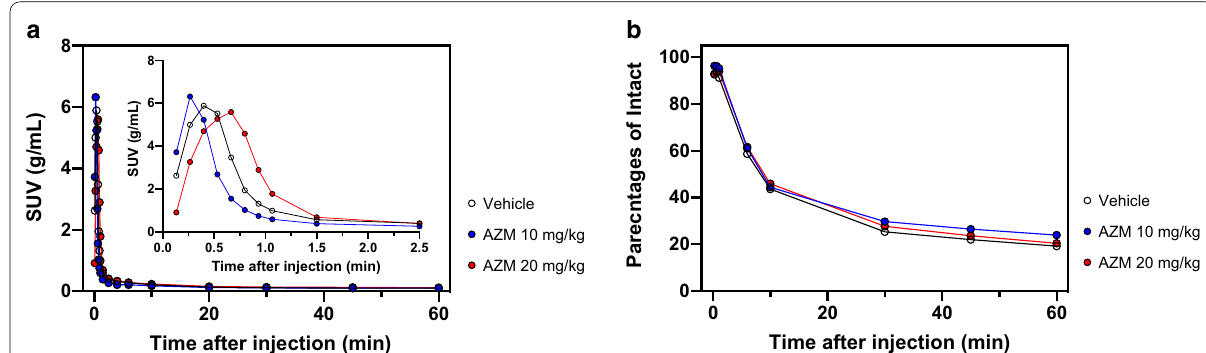
Fig. 3 Decay-corrected TACs of metabolite-corrected plasma ( a ) and percentage of intact [ 11 C] 4 ( b ) after intravenous injection of [ 11 C] 4 into monkeys. Values for 2.5 min were extracted from a and inserted